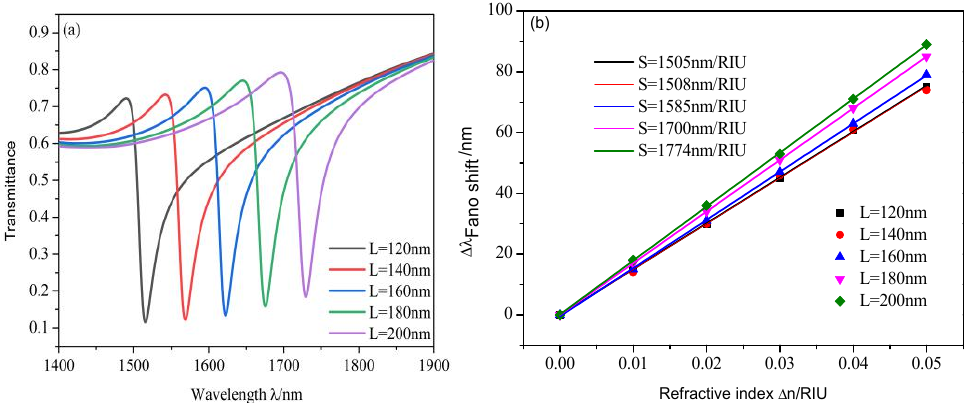
Figure 7. ( a ) Transmission spectra of the different length of the racetrack ring resonator L ; ( b ) linear fitting of the sensitivity.